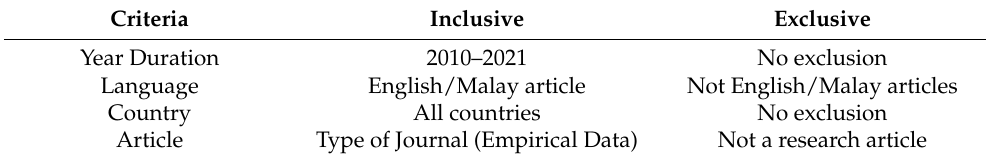
Table 2. Article-Finding